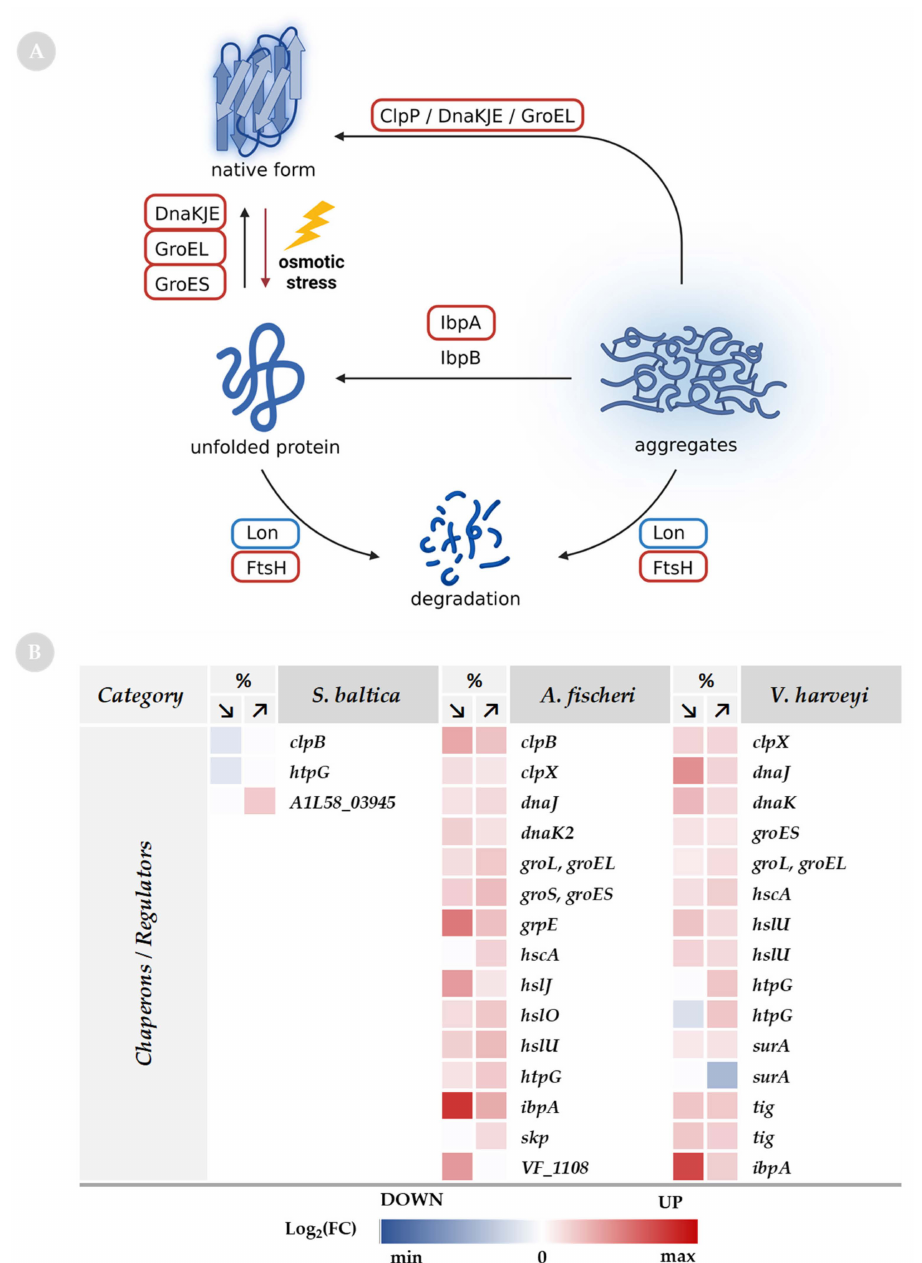
Figure 9. Osmotic stress induces response to misfolded and aggregated proteins in A. fischeri and V. harveyi . ( A ) Schematic representation of the recruitment of chaperones and proteases to maintain cellular proteostasis. The upregulated proteins are marked in red boxes and the downregulated ones in blue boxes. ( B ) Heatmaps of the abundance of chaperone proteins in S. baltica , A. fischeri , and V. harveyi following low- and high-salinity stress. In the header, upwards- and